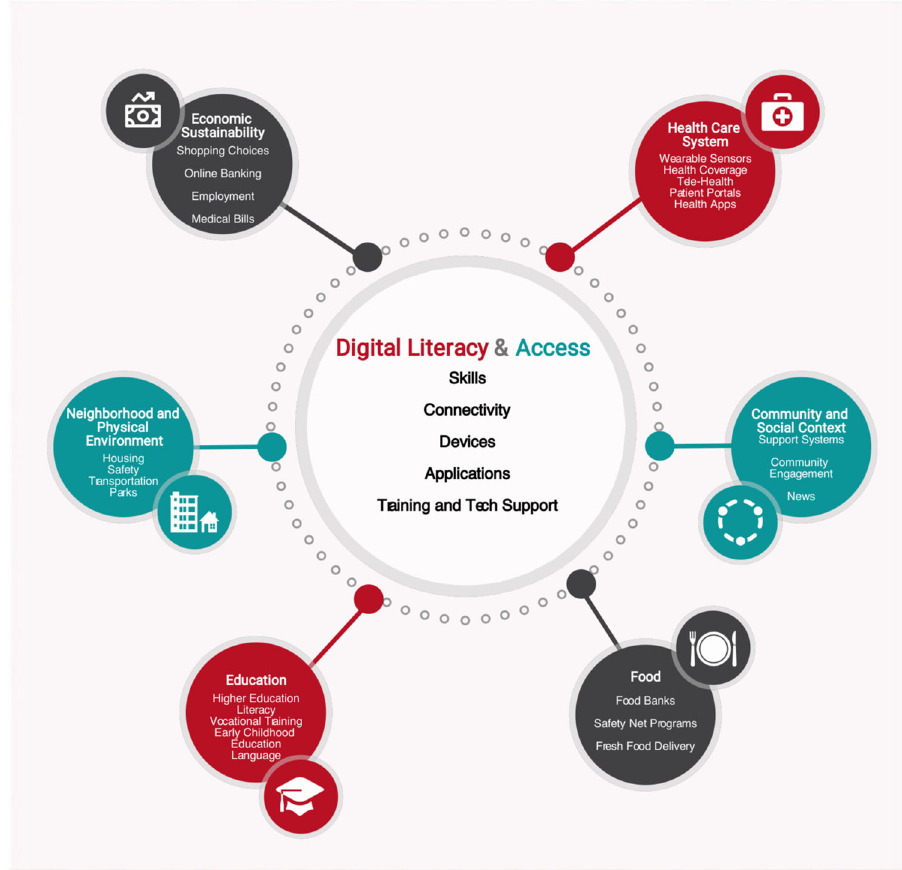
Fig. 1 Digital literacies and social determinants of health. Digital literacy and access, including skills, connectivity, devices and training and technical support, relate to all other domains of social determinants of